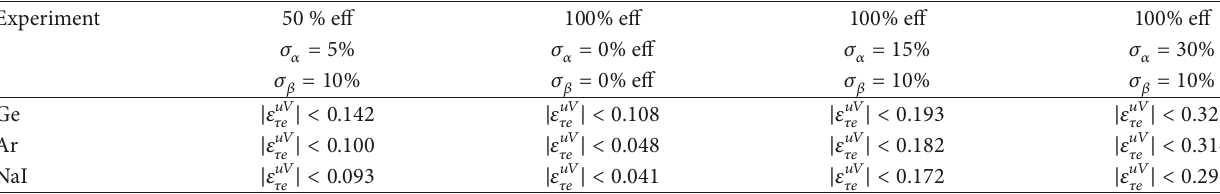
Table 3: Expected sensitivity to the flavor changing NSI parameter 𝜀 𝑢𝑉 𝜏𝑒 . For each experiment we quote the 90 % CL expected sensitivity for the different scenarios that we have considered.